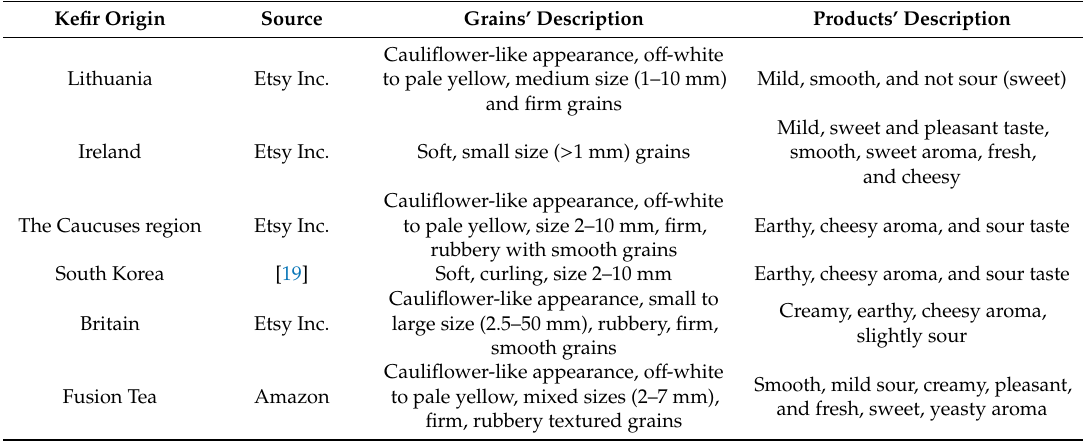
Table 1. Artisanal kefir origin, source, grains’ description and products’